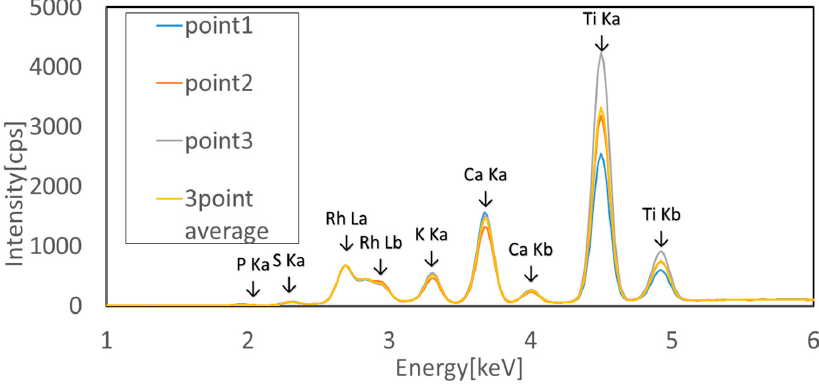
Figure 22. Normalised fluorescence X-ray spectroscopic data of strong leaf.